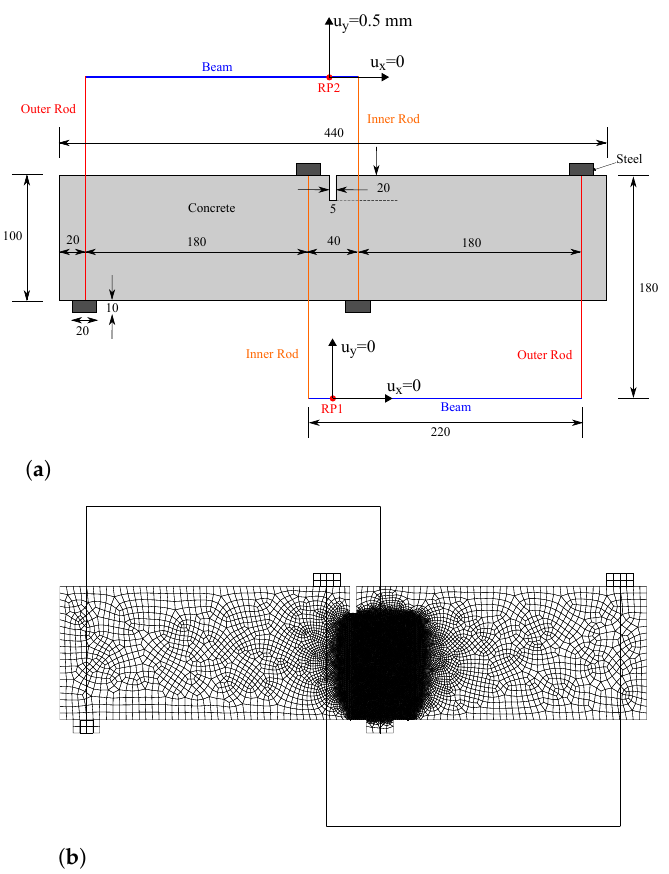
Figure 4. Mixed-mode fracture of a concrete beam: ( a ) geometry, dimensions (in mm) and boundary conditions, and ( b ) finite element